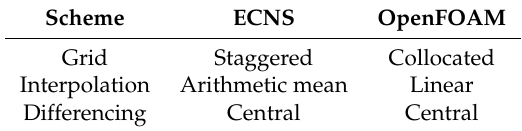
Table 1. Salient features of the two dissipation-free spatial discretisation methods studied in this article. Scheme ECNS OpenFOAM Grid Staggered Collocated Interpolation Arithmetic mean Linear Differencing Central